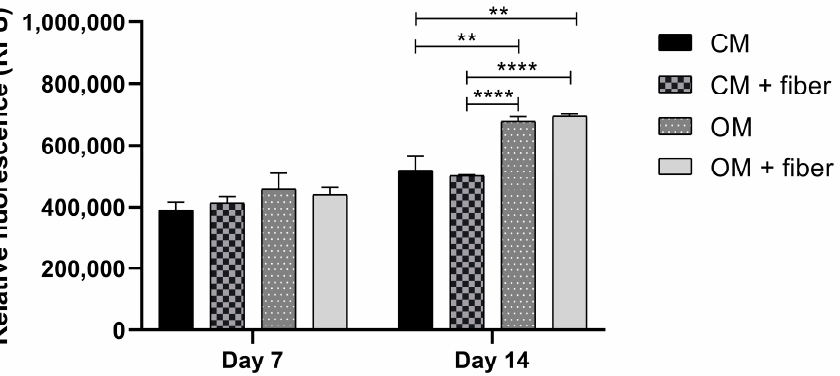
Figure 8. Cell viability assay of DPSC cells: cells were cultured with (CM+ and OM+) or without (CM and OM) BTCP-AE-FM samples for 7 and 14 days. After the incubation period, cell viability was assessed by alamarBlue assay. Values are expressed as sample means; error bars represent the standard deviation (SD) of three parallel measurements. In the t -tests, ** denotes p < 0.01, and **** denotes p < 0.0001. CM: control medium. OM: osteoinductive medium.